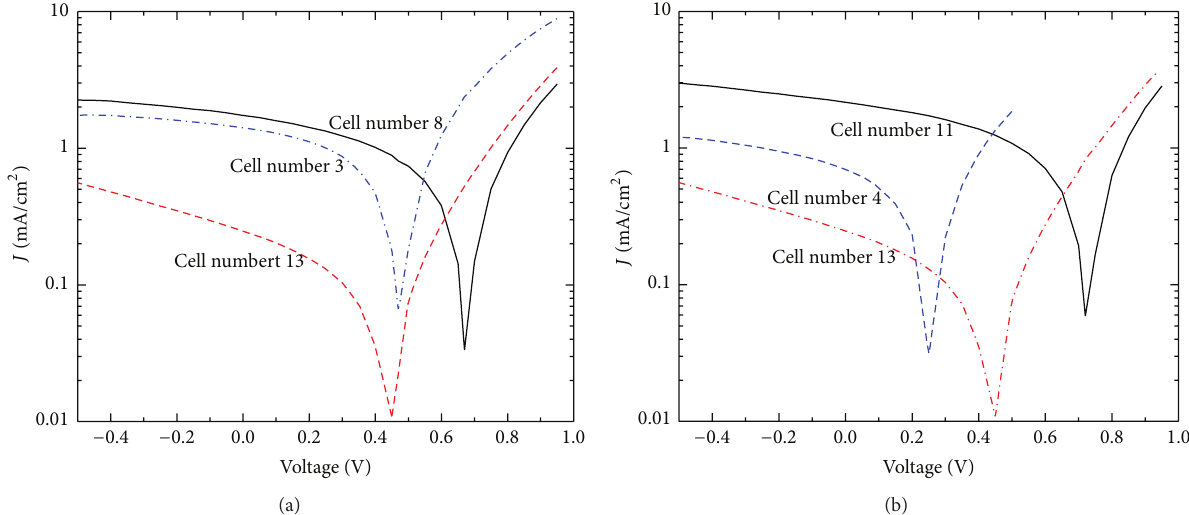
Figure 6: J-V semilogarithmic curves of the best hybrid solar cells with active layers of (a) diffused CdS-n/P3HT (cell number 3 in Table 2; cells numbers 8 and 13 in Table 3) and (b) bulk CdS-n:P3HT layers (cell number 4 in Table 2; cells numbers 11 and 13 in Table 3).